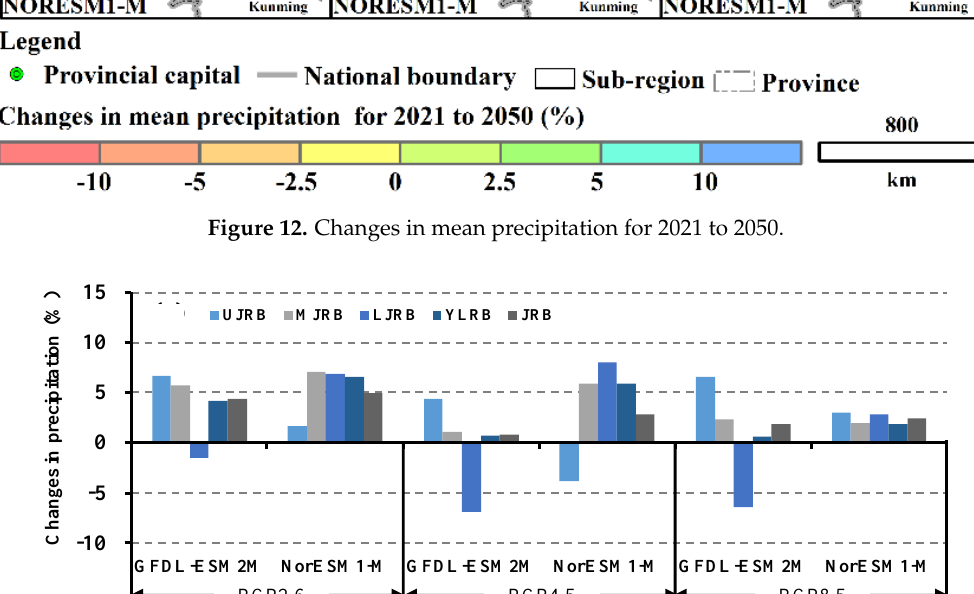
Figure 13. Changes in mean precipitation for 2021 to 2050 in different regions.